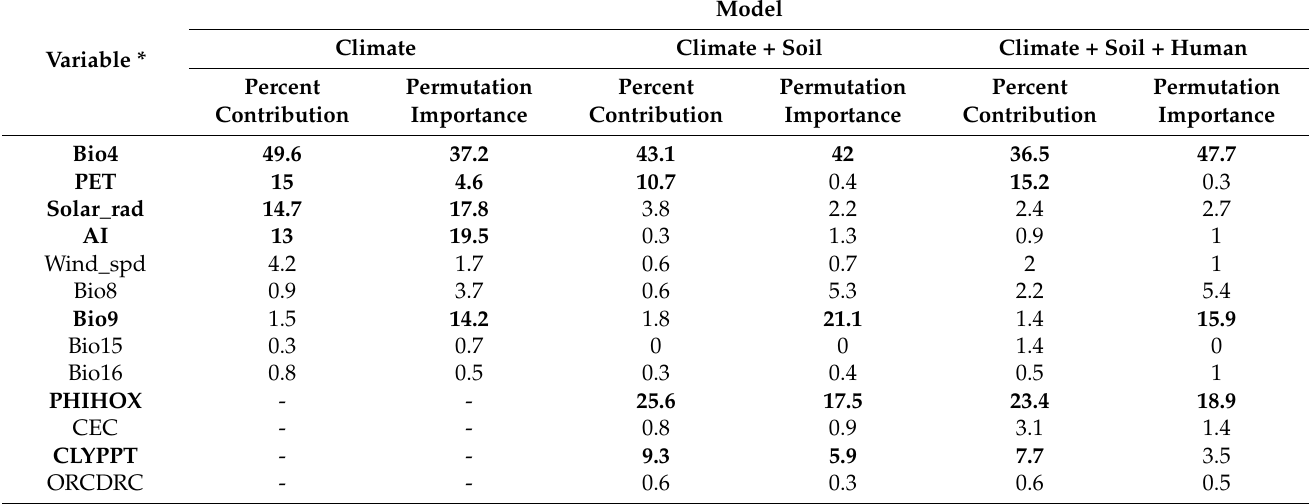
Table 2. The relative contributions and importance of the climatic, edaphic, and human factors to the potential invasion risk of P. juliflora . The sensitivity, true skill statistic (TSS), and the area under the receiver-operating characteristic curve (AUC) indicate the performance or accuracy of the three models generated by MaxEnt. The most important variables and their values are shown in